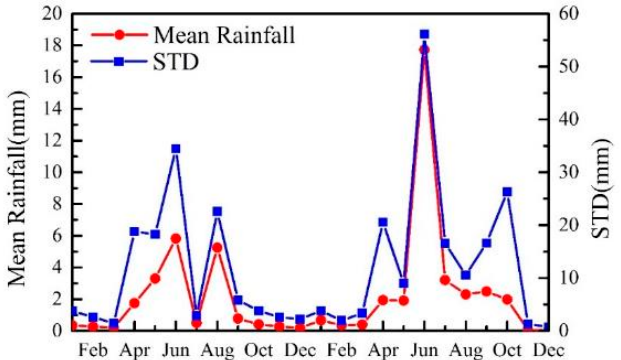
Figure 5. Monthly mean rainfall and its standard deviation (STD) at Lau Fau Shan meteorological station in 2007 and 2008.